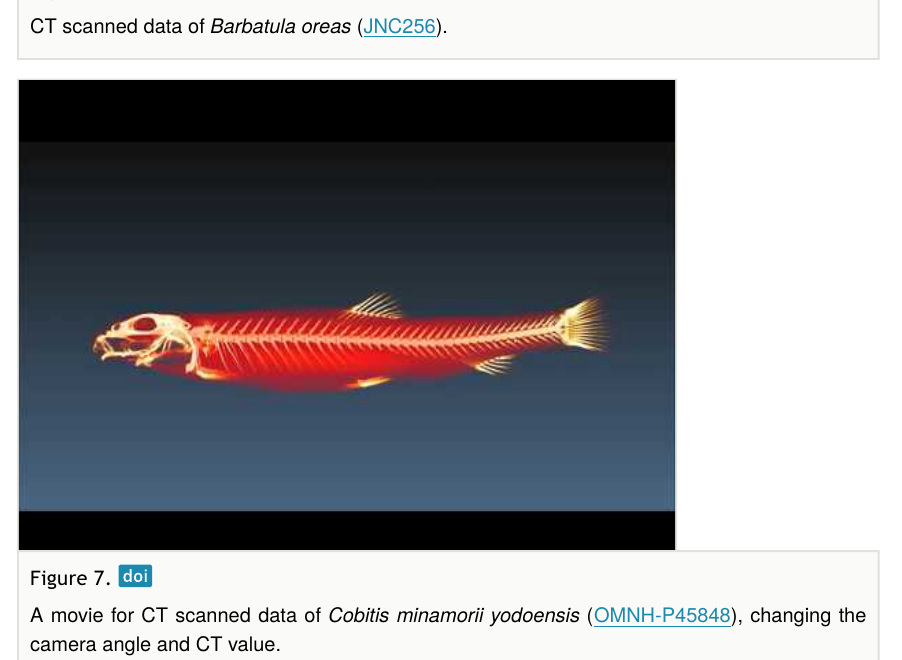
Figure 7. A movie for CT scanned data of Cobitis minamorii yodoensis (OMNH-P45848), changing the camera angle and CT